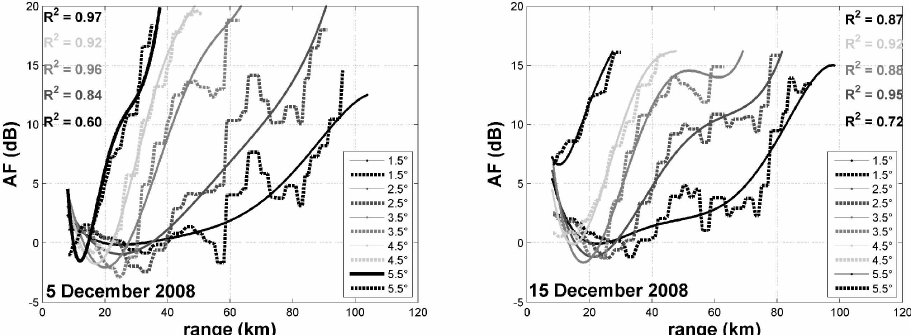
Fig. 9. AF trends with range computed for the 5 December 2008 and the 15 December 2008 cold-season convective events by using both a polynomial fit of the fifth order (solid lines) and a method of moving averages with a window of 15km (dashed curves). Curves are obtained for different elevation angles ranging from 1.5 to 5.5 ◦ .